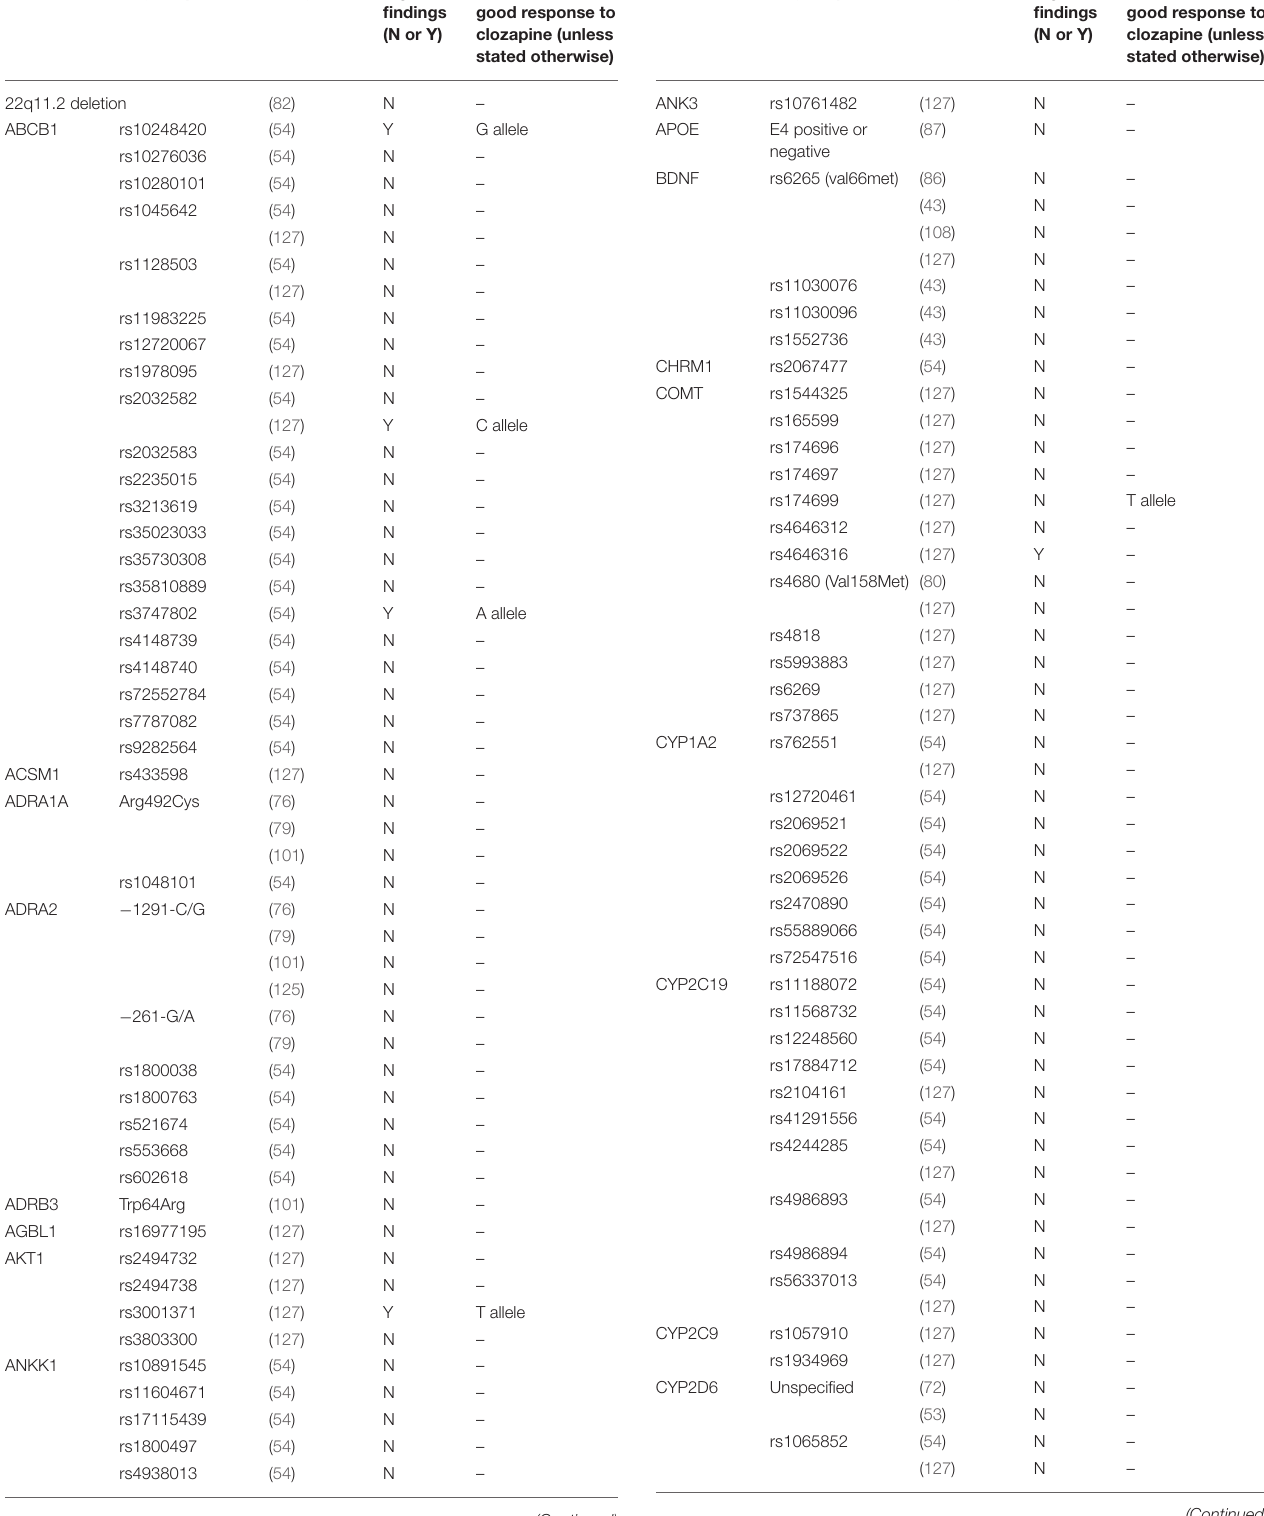
TABLE 9 | Results for individual genetic variants. Polymorphism Study Significant